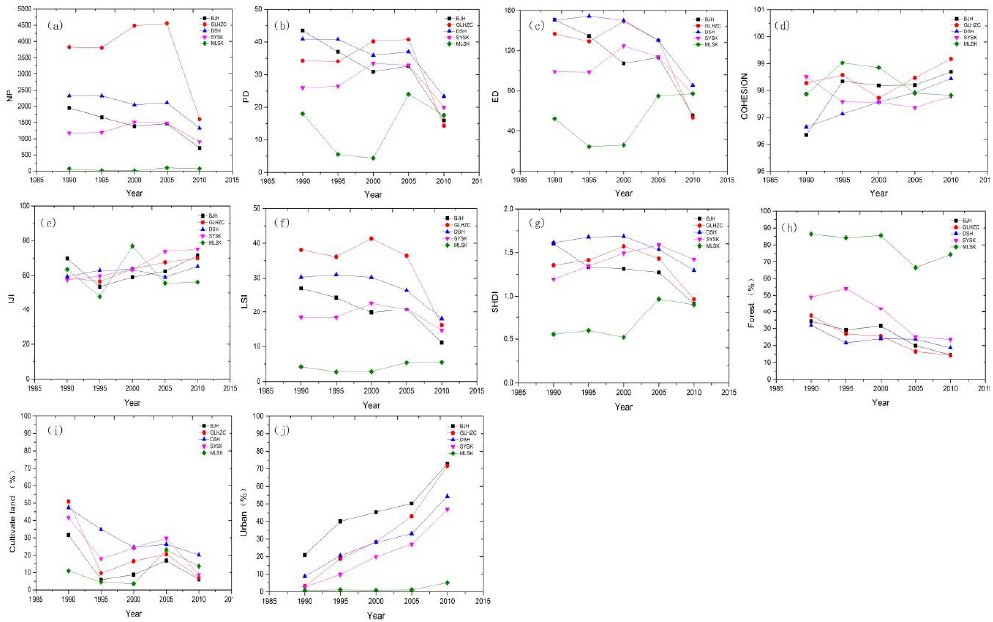
Figure 5. Landscape changes in five typical watersheds from 1990 to 2010, ( a ) NP; ( b ) PD; ( c ) ED; ( d ) Cohesion; ( e ) IJI; ( f ) LSI; ( g ) SHDI; ( h ) ForestP; ( i ) CultiP; ( j ) UrbanP.